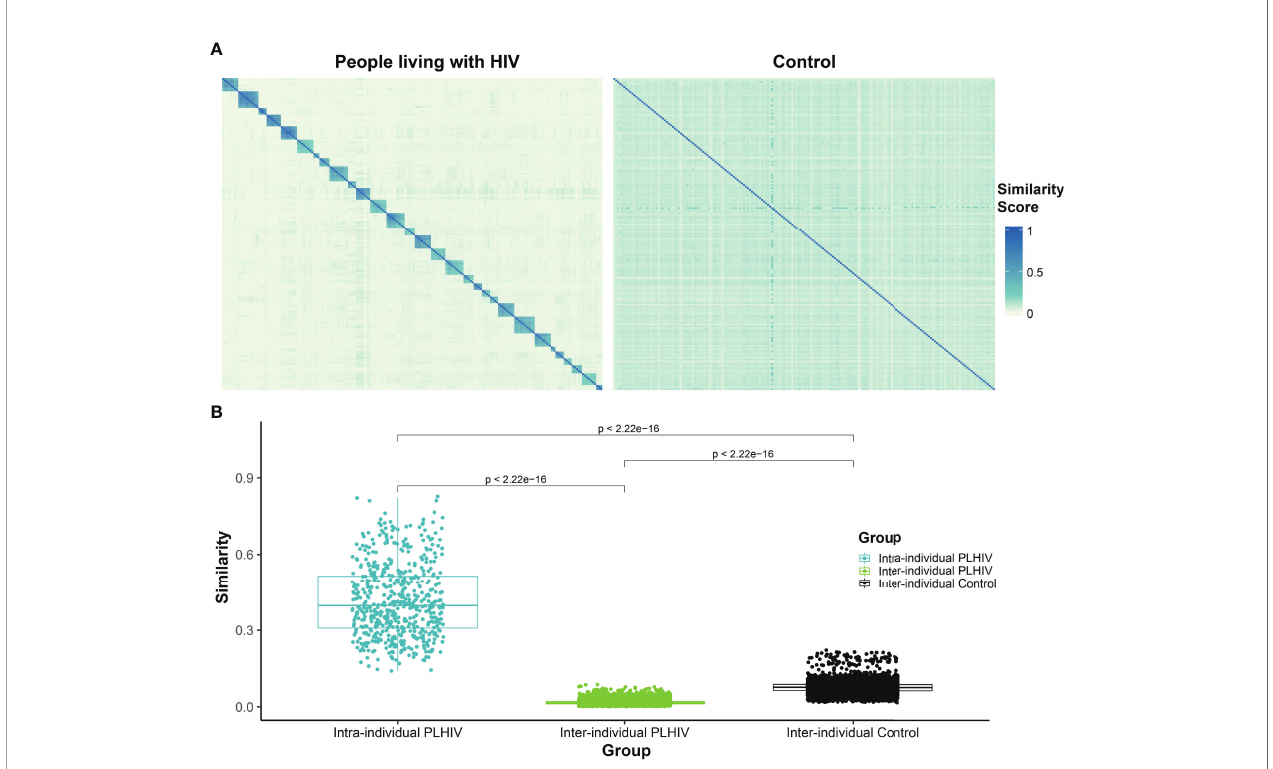
FIGURE 5 | T-cell b -chain repertoires of PLHIV demonstrate signi fi cantly less inter-individual similarity than control repertoires. (A) Heatmap of pairwise similarity scores between the repertoires of 30 PLHIV (left) and between 189 control bone marrow transplant donors (right). In the PLHIV cohort, repertoires are ordered by participant ID followed by the date of sample collection. (B) Boxplot demonstrating the distribution of pairwise similarity scores within-participants and across- participants in the PLHIV cohort and in the control cohort.